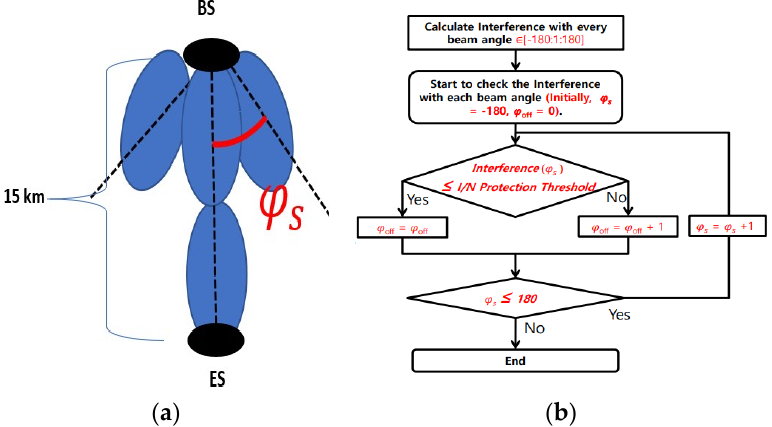
Figure 4. Fixed base station—earth station: ( a ) relative azimuth and ( b ) flux gram [7].